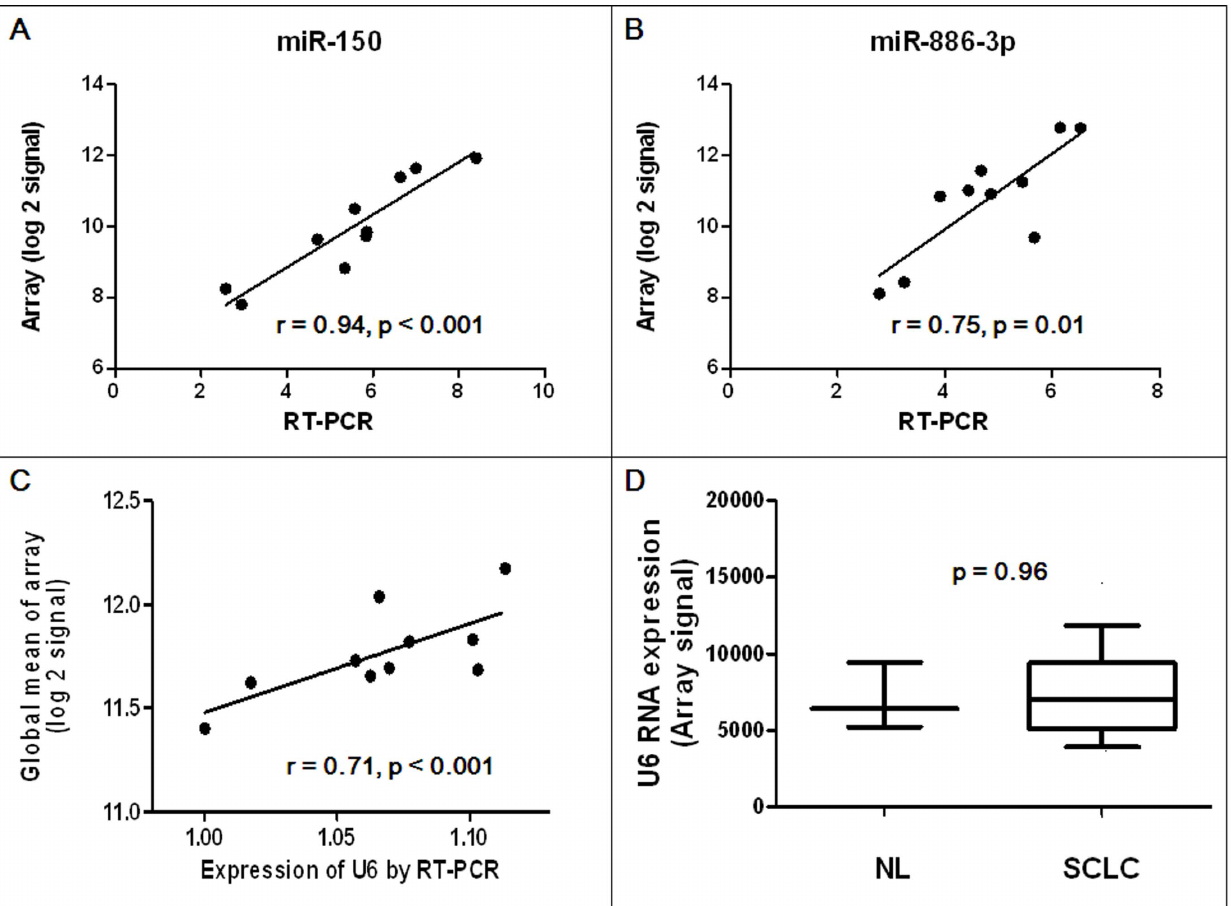
Figure 3. Correlation between RT-PCR Ct and log 2-transformed array signal intensity values for (A) miR-150 and (B) miR-886-3p. (C) Correlation between expression of U6 RNA by qRT-PCR and log 2-transformed global mean array expression. (D) Expression of U6 RNA in human normal lung (NL, n=3) and small-cell lung cancer (SCLC, n=42) samples by microarray method. Whiskers depict the 10 and 90 percentiles. p value is calculated by the Mann-Whitney U test.